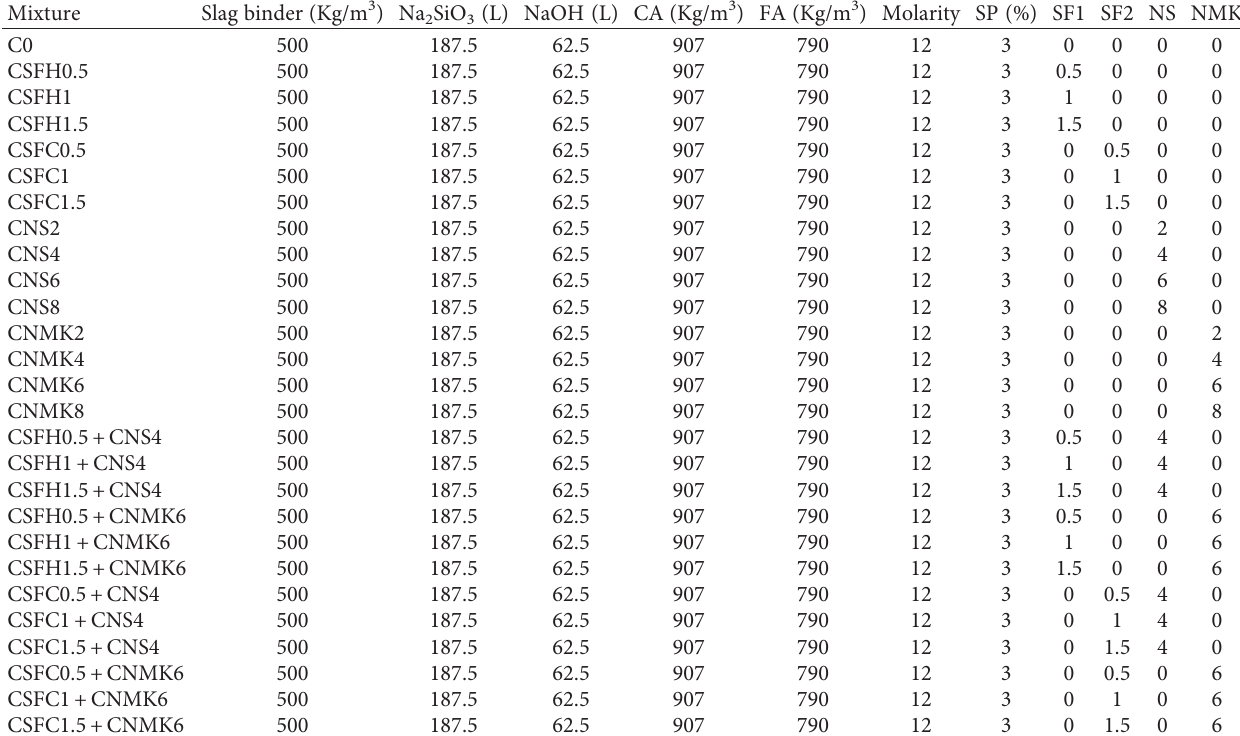
Table 4: Geopolymer mix proportions in kg/m 3 .